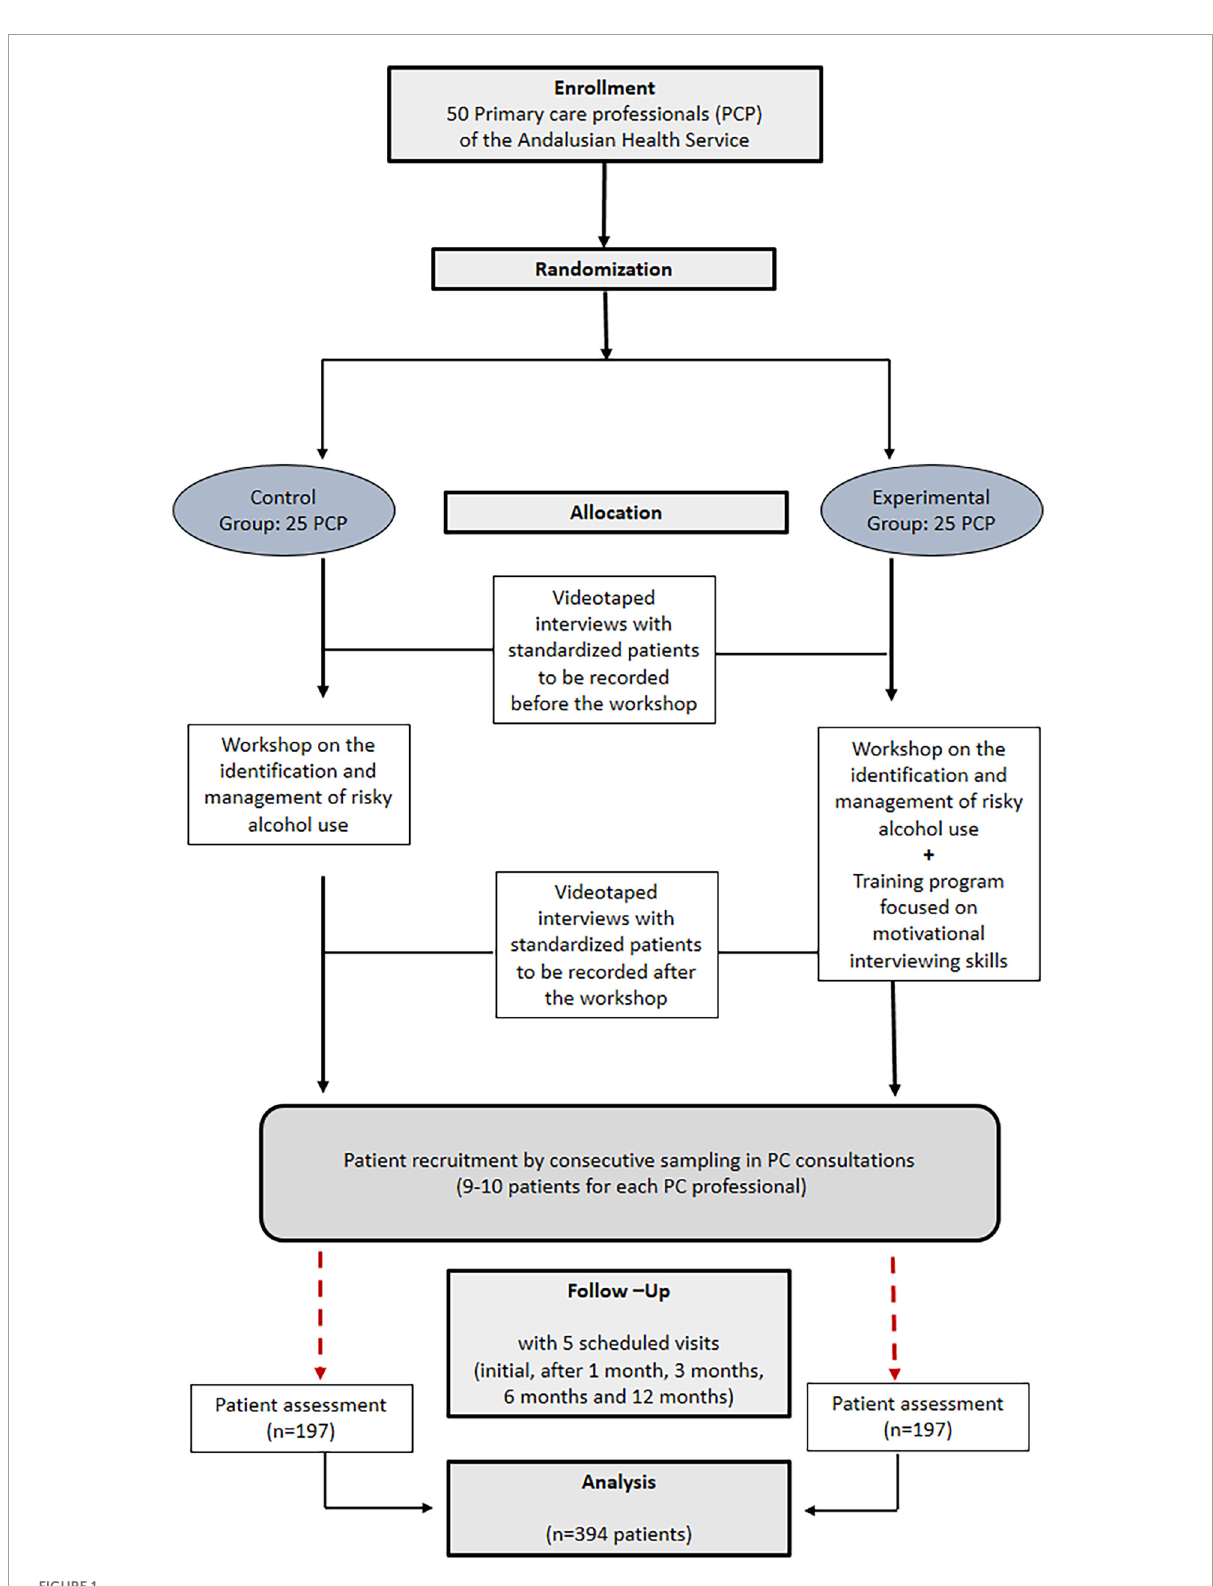
FIGURE1 Cluster-randomized trial intervention